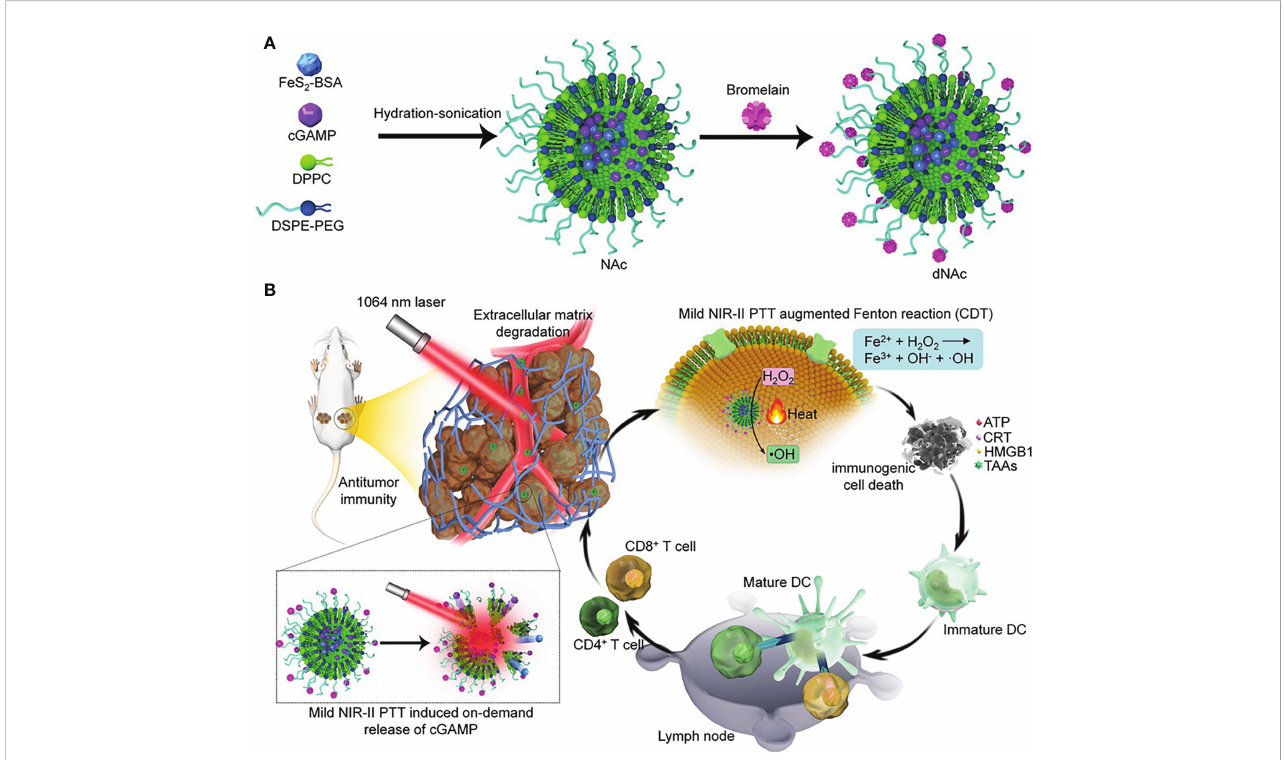
FIGURE 3 Nanomedicine loaded with 2 ’ 3 ’ -cGAMP as STING agonists for tumor immunotherapy. (A) Schematic illustration of the synthesis route of ECM-degrading LNPs (dNAc). (B) Schematic illustration of NIR-II photoactivation of dNAc for mild photothermal effect-augmented CDT combined with STING activation for immunotherapy. Reproduced from Ref. (36) with permission. Copyright 2022 Springer